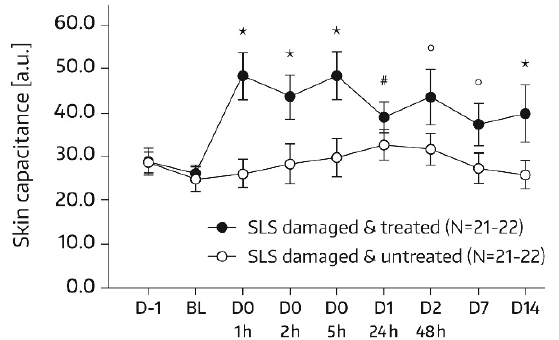
Figure 9. Results from skin capacitance measurements in untreated SLS-damaged skin and SLS- damaged skin undergoing a single application of Emollient 3 (first 48 h) followed by once-daily application for 12 days. The values were assessed by corneometry and are presented as mean ± SD. SLS challenge started on day -1 and ceased 24 h later (30 min before BL assessment). BL = Baseline skin capacitance value before first product application; D = day; h = hour; SLS = sodium lauryl sulfate. * p < 0.001 if compared to untreated control, paired t -test. # p = 0.018 if compared to untreated control, paired t -test. ◦ p = 0.001 if compared to untreated control, paired t -test.